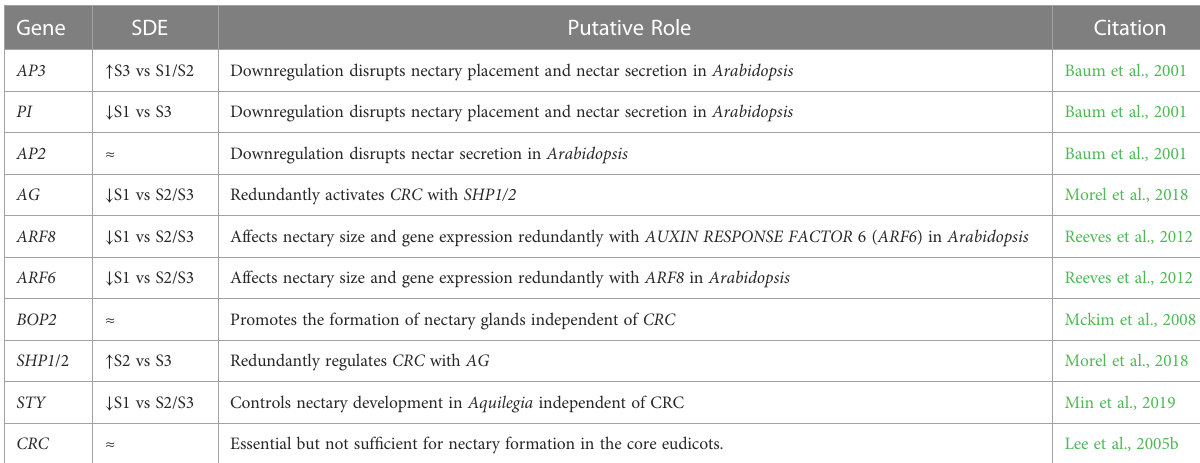
TABLE 3 Genes of interest with direct roles in nectary formation with relative expression values from our transcriptomic dataset, putative roles and relevant citations. Gene SDE Putative